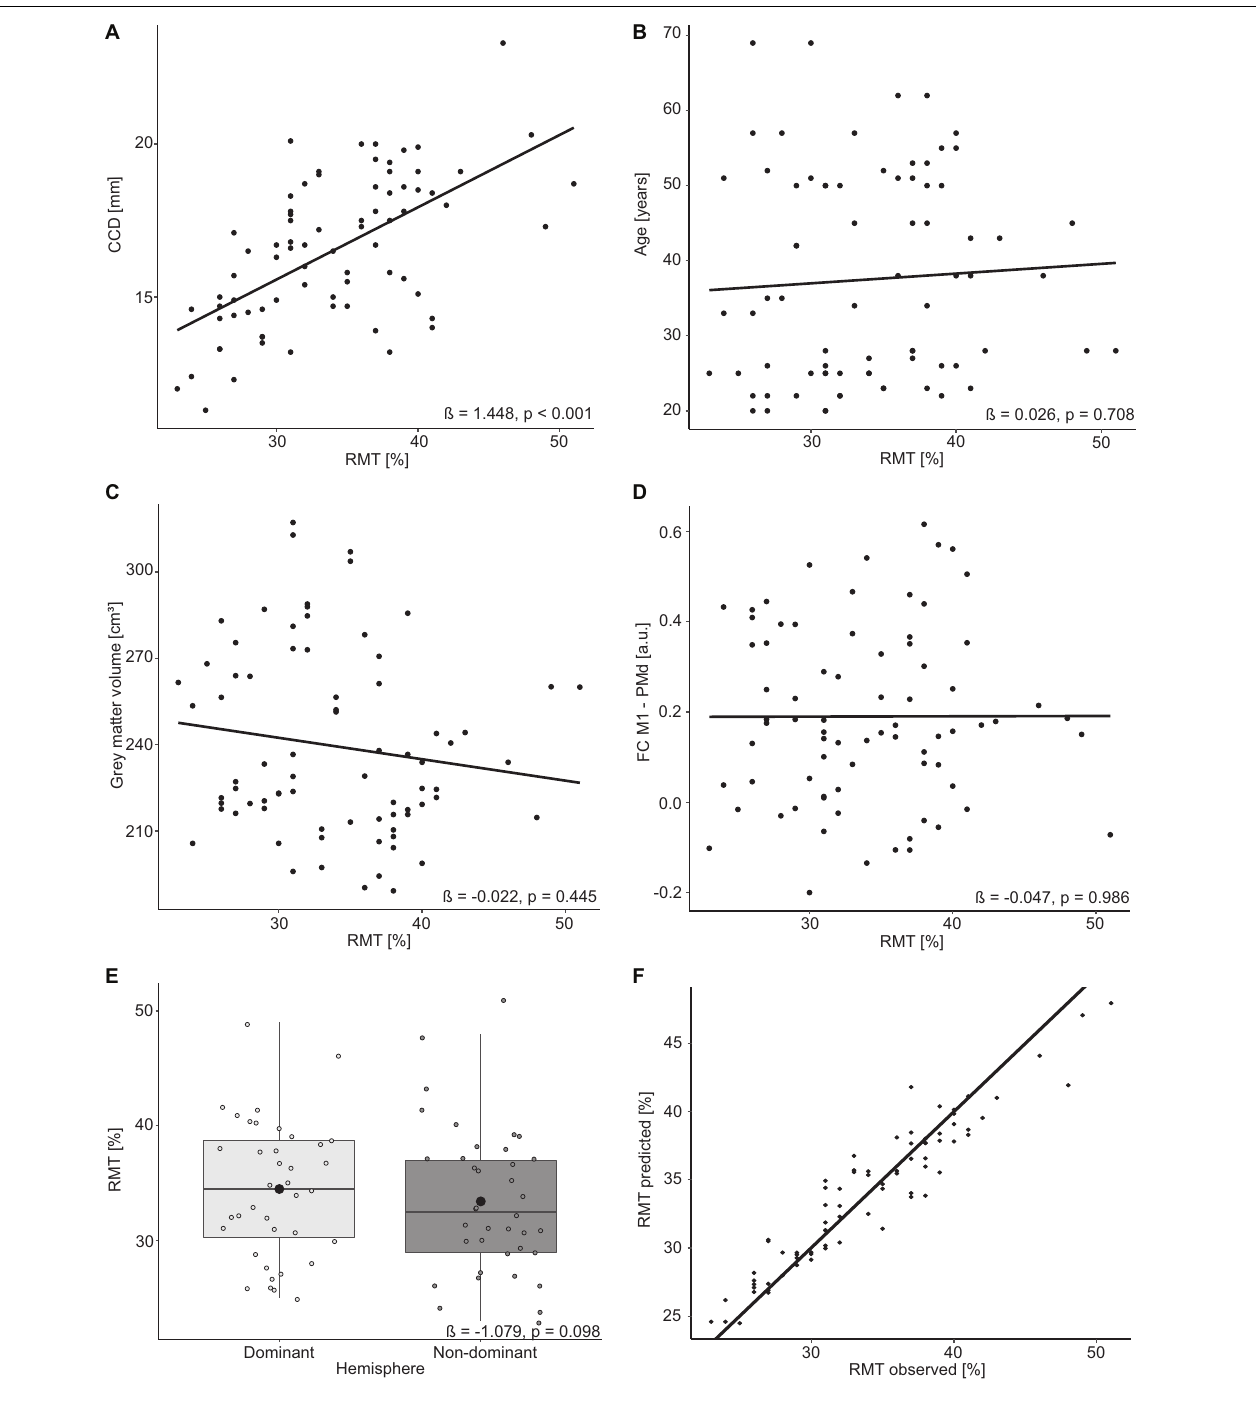
FIGURE 2 | Linear mixed model analysis for both hemispheres. Regression lines between RMT (%) and CCD (A) , age (B) , gray matter volume (C) , and FC M1–PMd (D) . (E) The effect of the hemisphere on the RMT. Large black dots correspond to the mean RMT for each hemisphere. (F) Observed RMT versus RMT predicted by the model. The diagonal line represents perfect